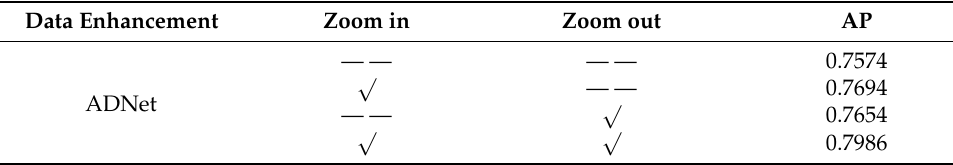
Table 1. Effects of data enhancement.